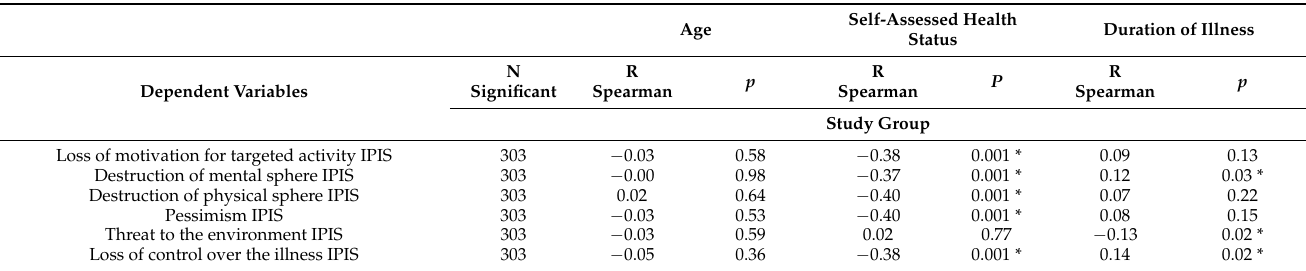
Table 5. Perception of own illness as measured by IPIS vs. age, self-assessed health status and duration of illness of the respondents. Age Self-Assessed Health